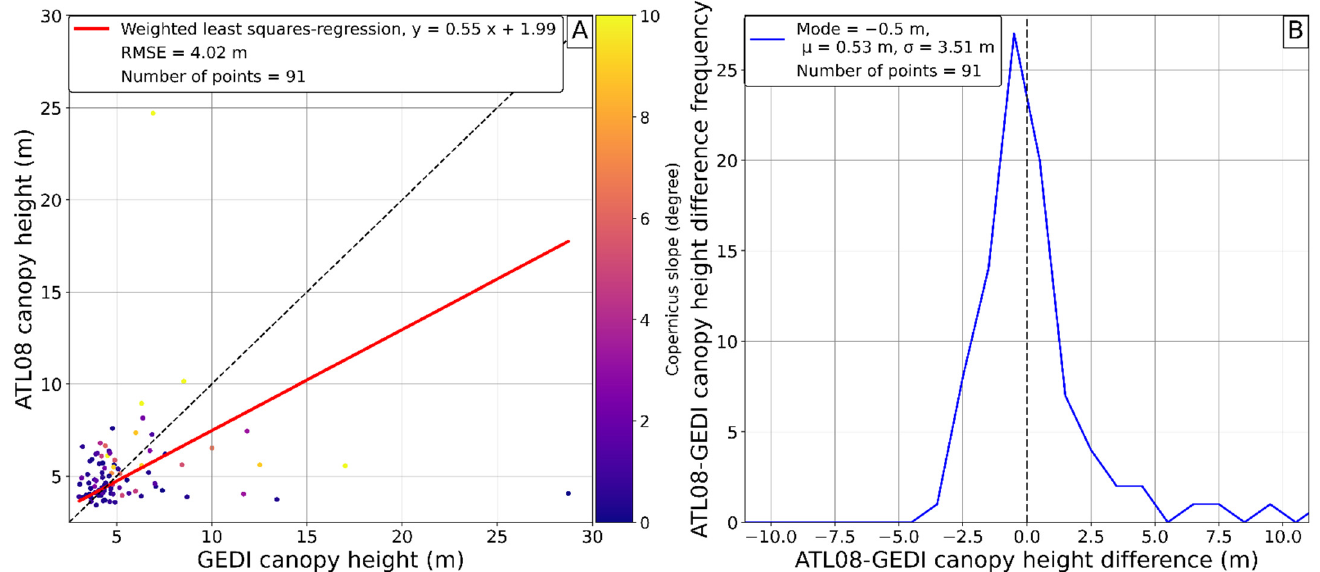
Figure 12. GEDI and ATL08 canopy height relationship ( A ) and the distribution of ATL08 minus GEDI canopy heights ( B ). Comparison is based on 91 overlapping measurements within a buffer of 5 m and was carried out on the entire study area shown by the red polygon in Figures 1B,C and 2. Red line shows the weighted least squares-regression, where the inverse of canopy height difference between ATL08 and GEDI measurements were used as weights.